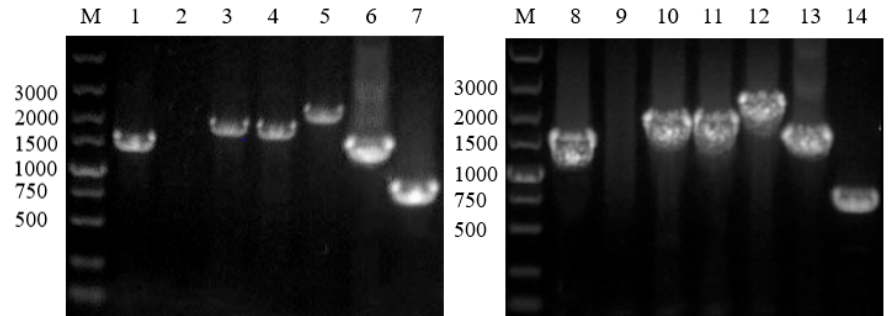
Figure 7. ORFs 0934 and 0492 gene knockout construction examined by PCR. Lane M represents the molecular markers, Lane 1 indicates the amplification of the sequence of the kanamycin resistance gene in ∆ ORF 0934, Lane 2 the ORF 0934 fragment in ∆ ORF 0934 (no band), Lane 3 the sequence of the kanamycin resistance gene in ∆ ORF 0934 + upstream homologous arm, Lane 4 the sequence of the kanamycin resistance gene in ∆ ORF 0934 + downstream homologous arm, Lane 5 the full length of the kanamycin resistance gene cassette of ∆ ORF 0934, Lane 6 the control of the kanamycin resistance gene (with the pKD4 plasmid as the template), Lane 7 the ORF 0934 fragment in the wild type (WT), Lane 8 the amplification of the sequence of the kanamycin resistance gene in ∆ ORF 0492, Lane 9 the ORF 0492 fragment in ∆ ORF 0492 (no band), Lane 10 the sequence of the kanamycin resistance gene in ∆ ORF 0492 + upstream homologous arm, Lane 11 the sequence of the kanamycin resistance gene in ∆ ORF 0492 + downstream homologous arm, Lane 12 the full length of the kanamycin resistance gene cassette of ∆ ORF 0492, Lane 13 the control of the kanamycin resistance gene (with the pKD4 plasmid as the template), and Lane 14 the ORF 0492 fragment in the wild type